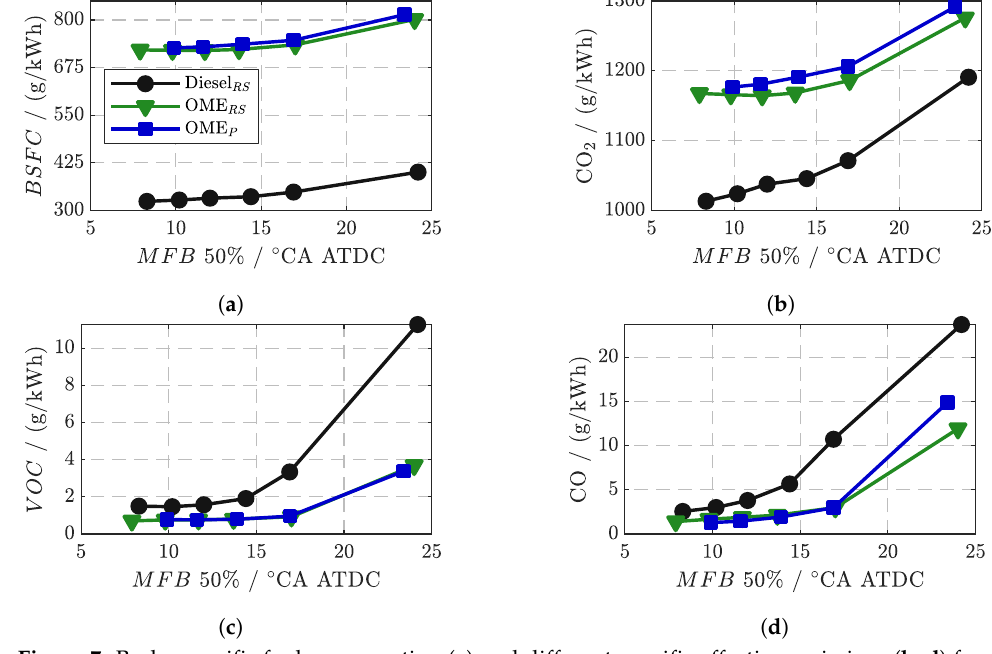
Figure 7. Brake-specific fuel consumption ( a ) and different specific effective emissions ( b – d ) for a variation of MFB 50% at OP 1 ( n = 2600 1/min, BMEP = 2.2 bar) for two different nozzles in OME